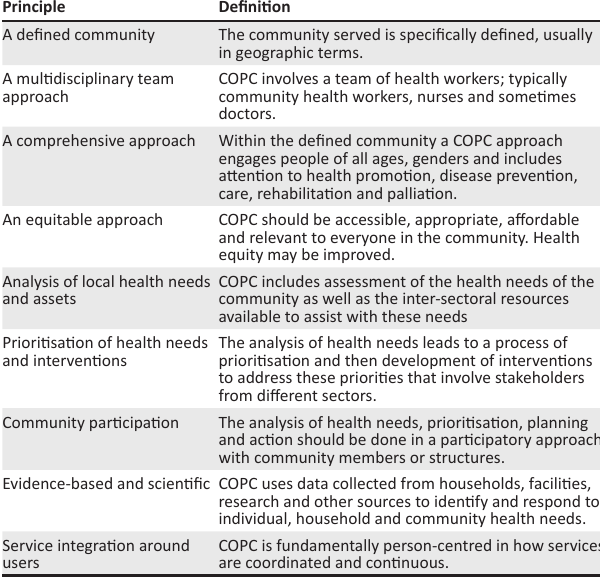
TABLE 1: Principles of community-orientated primary